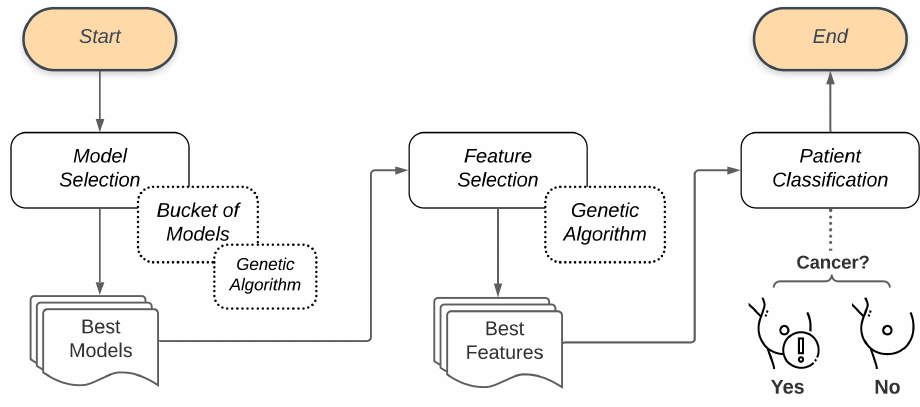
Figure 2. General flow of the proposed methodology.